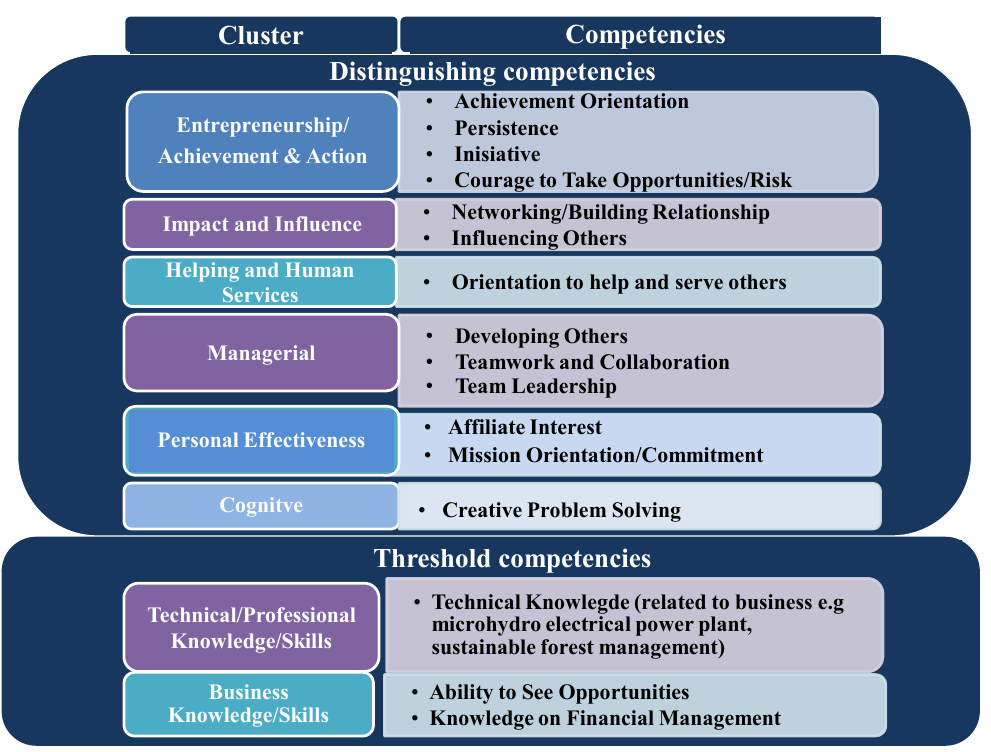
Figure 1: Competency of Successful Social Entrepreneurs Competency model is organized into cluster, competencies and behavioral indicators (Spencer and Spencer, 1993, p.159). The proposed competency model of social entrepreneurs formulated in this way (Table 2). Spencer and Spencer declare there are five types of competencies. Table 2 shows that when it is grouped into Spencer and Spencer competency nature, those competencies fall into five categories. This means the findings confirm Spencer and Spencer statement about types of